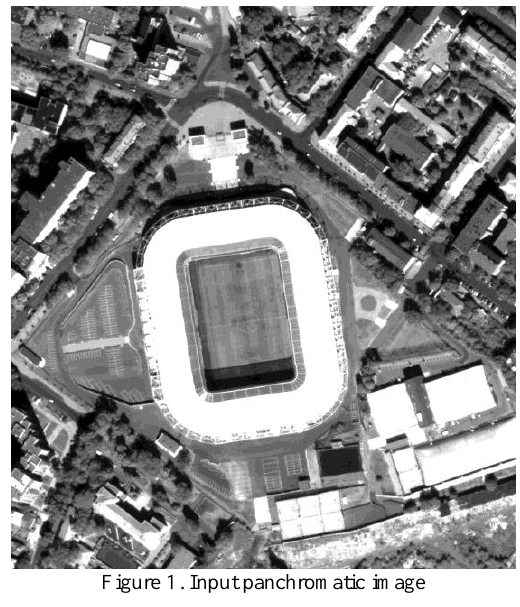
Figure 1. Input panchromatic image